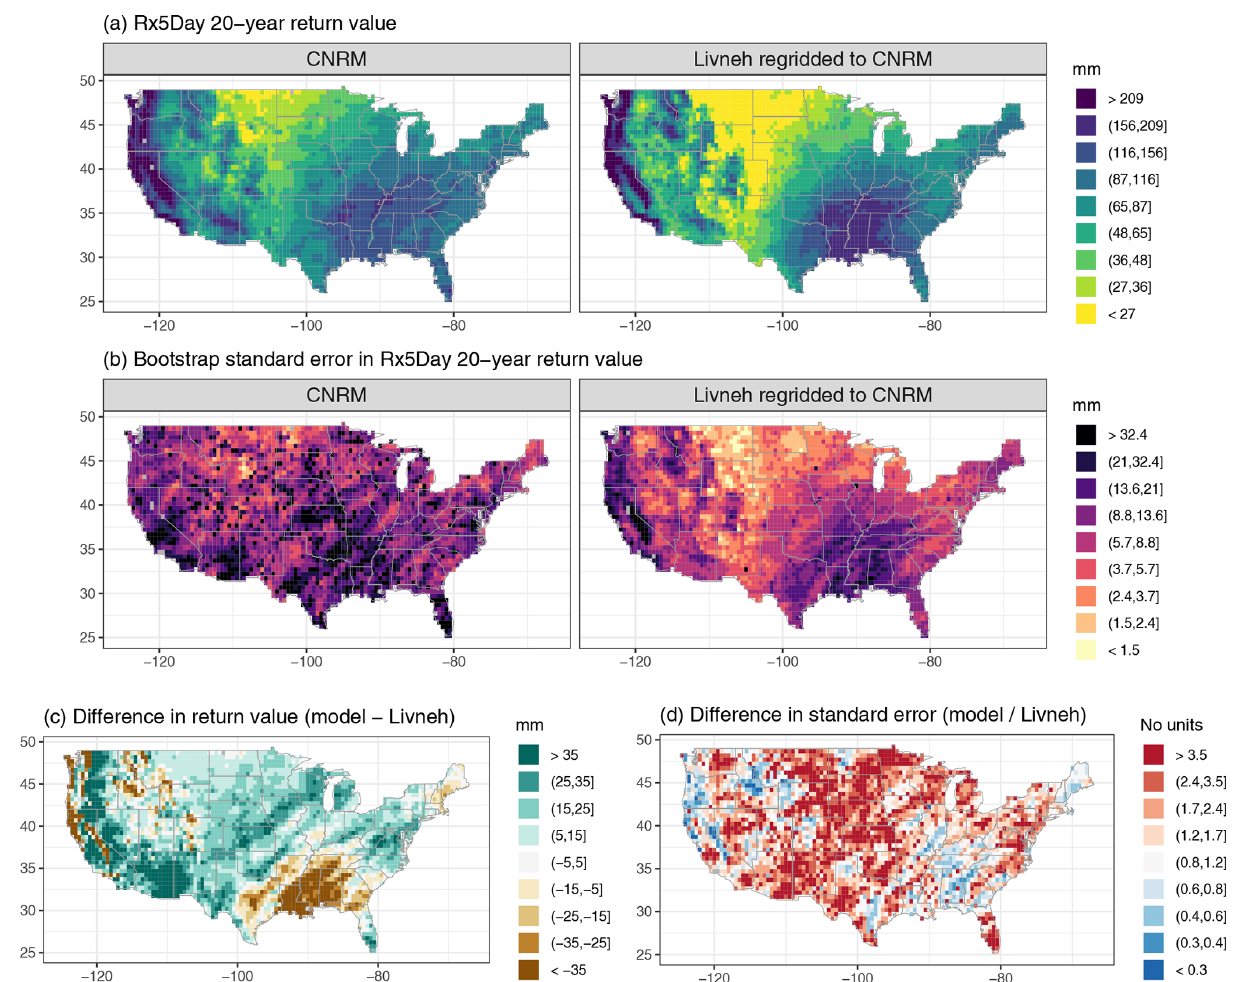
Figure A3. Wintertime (DJF) 20-year return values in Rx5Day (mm) for the CNRM model and regridded L15 (a) , with the bootstrap standard error (mm; b ). Also shown is the difference in return values (model minus regridded L15) as well as the ratio of standard errors (model divided by regridded